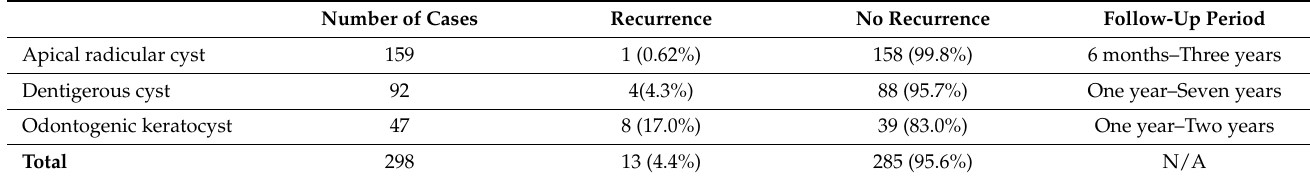
Table 6. Summary of the Treatment modalities of each odontogenic